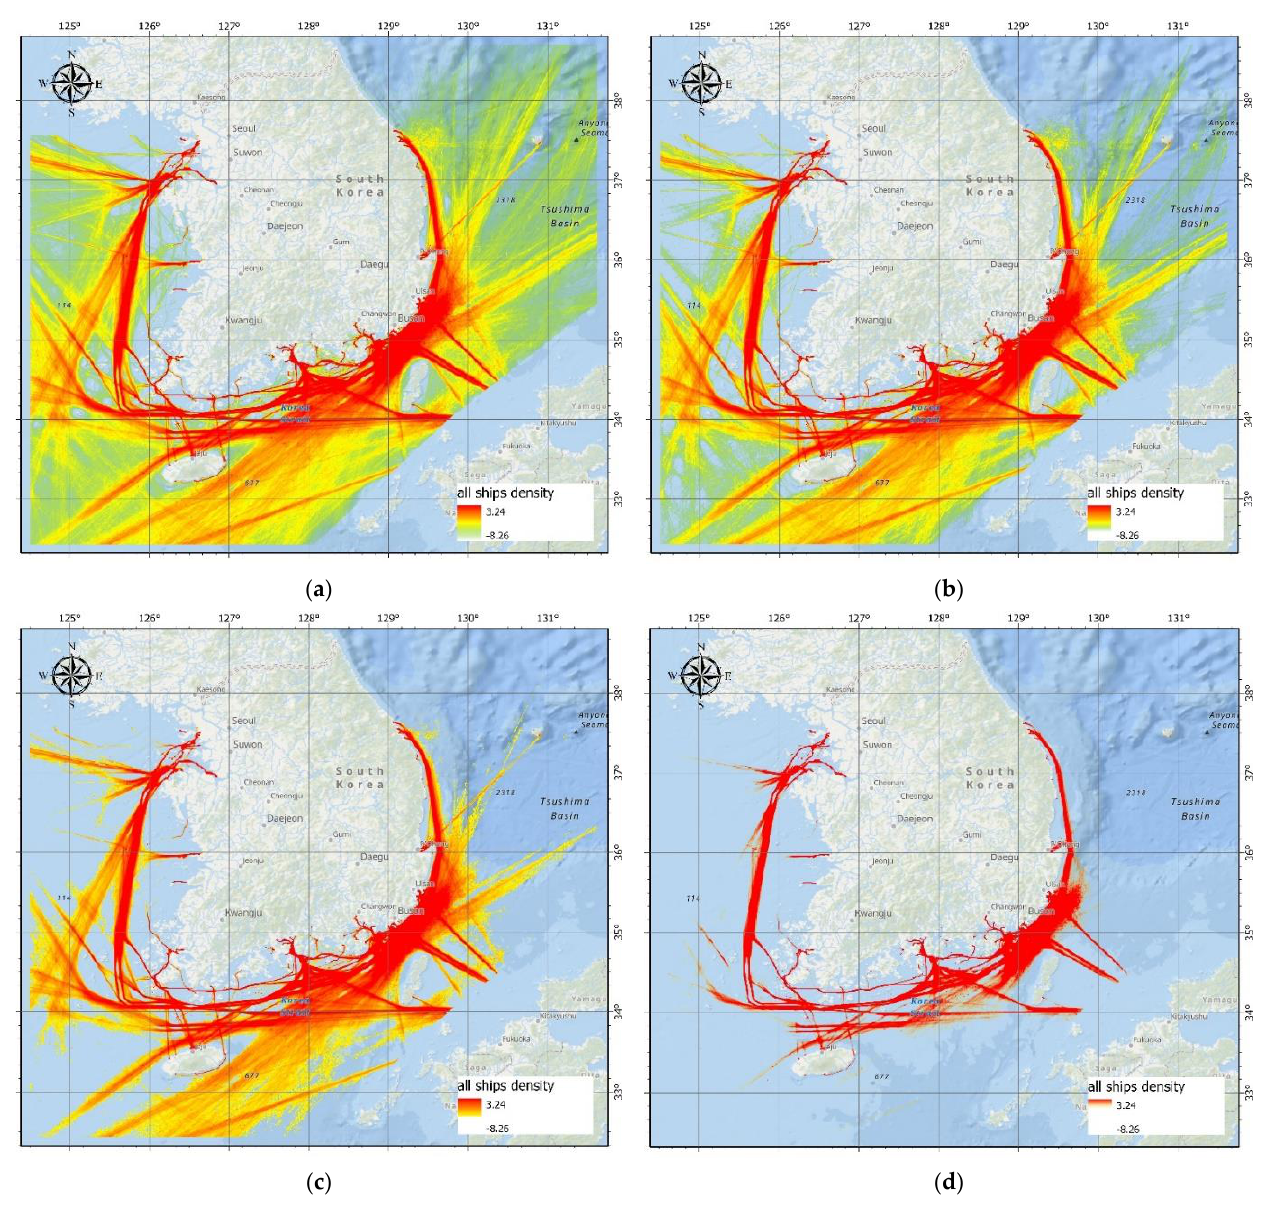
Figure 7. Visualization of log-transformed density values for all ships using the standard-deviation- based stretch symbolization. The continuous color scheme of stretching is applied to ( a ) 100%, ( b ) the top 75%, ( c ) the top 50%, and ( d ) the top 25% of the full range. The high-density routes were those that remained after sequentially reducing the total percentage of the stretch color ramp from 100% to the top 75%, 50%, and 25%. The